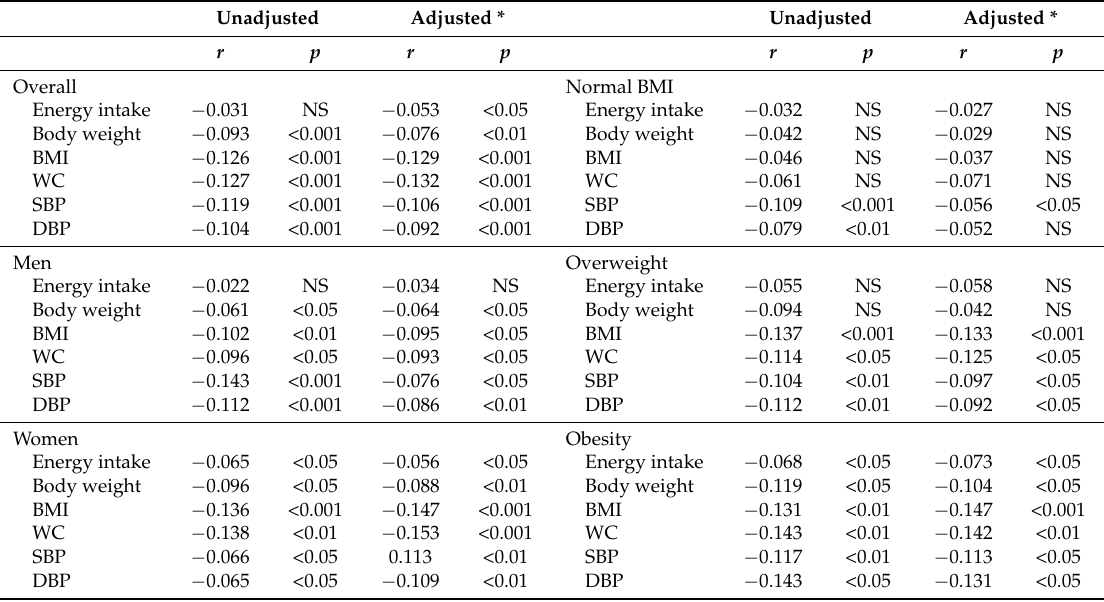
Table 2. Correlations between dietary histidine and energy intake, body weight, BMI, WC and blood